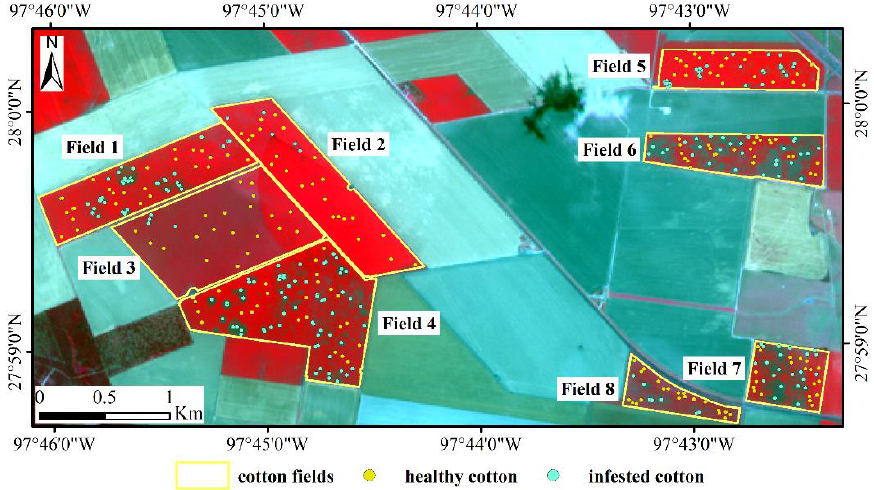
Figure 2. Sentinel-2A color infrared (CIR) composite image with ground verification points for the study